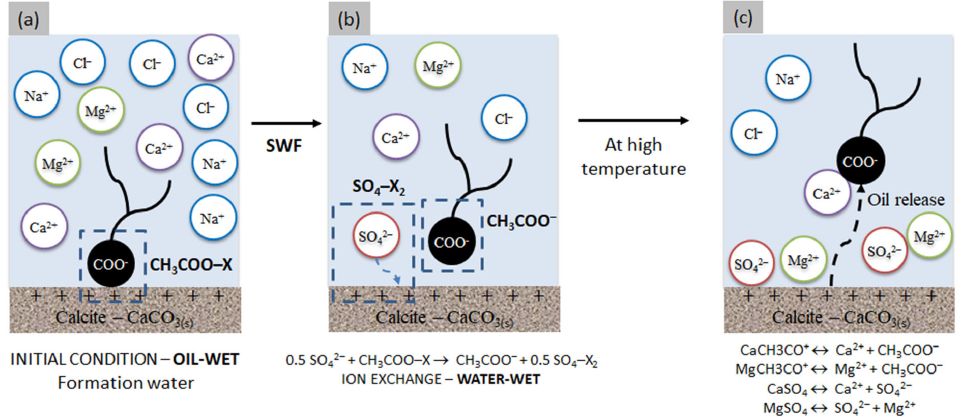
Figure 3. Schematic of smart water injection mechanisms.